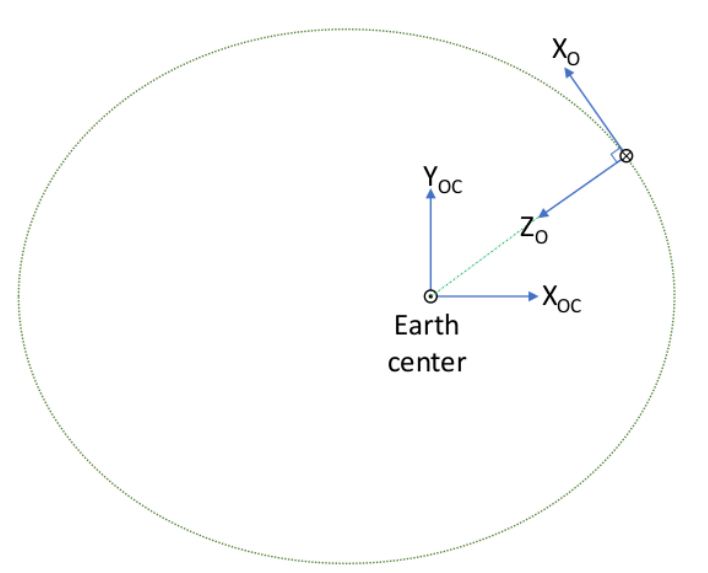
Figure 4. Earth centered orbit reference frame (OC) and orbit (O) reference frames.